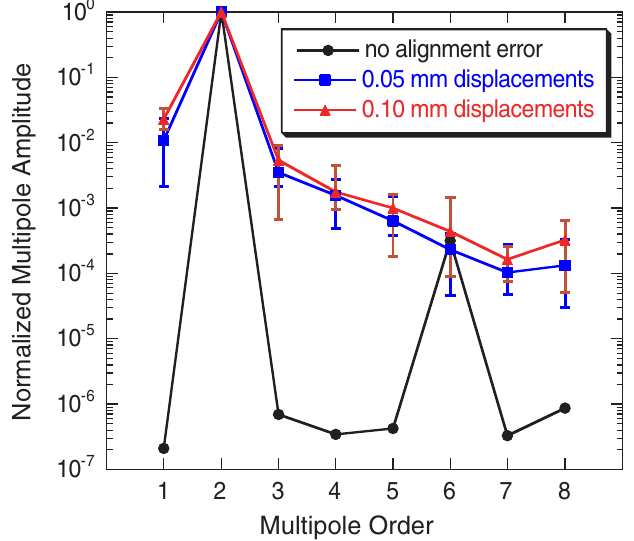
FIG. 2. (Color) Multipole amplitudes of nonlinear fields gener- ated by nonideal electrode shape and mechanical alignment errors in the Paul trap. Rms transverse displacement errors of the electrode rods assumed in these examples are 0.05 mm (blue) and 0.1 mm (red). In this example, ten different sets of Gaussian random numbers are used to define the displacements of four rods. The strengths of multipole fields have been normalized by the quadrupole